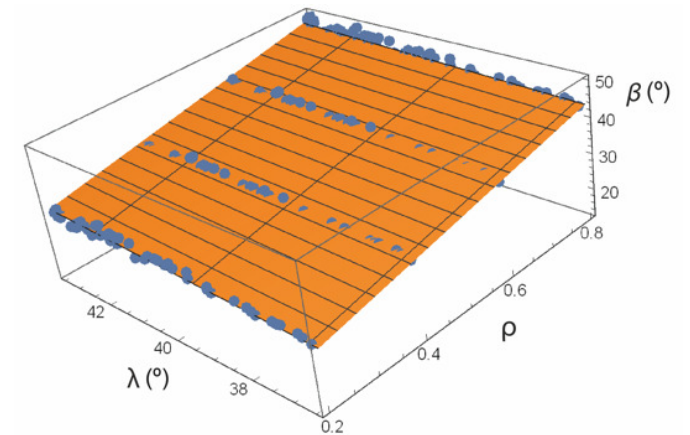
Figure 10. Fitting surface β ( λ , ρ )